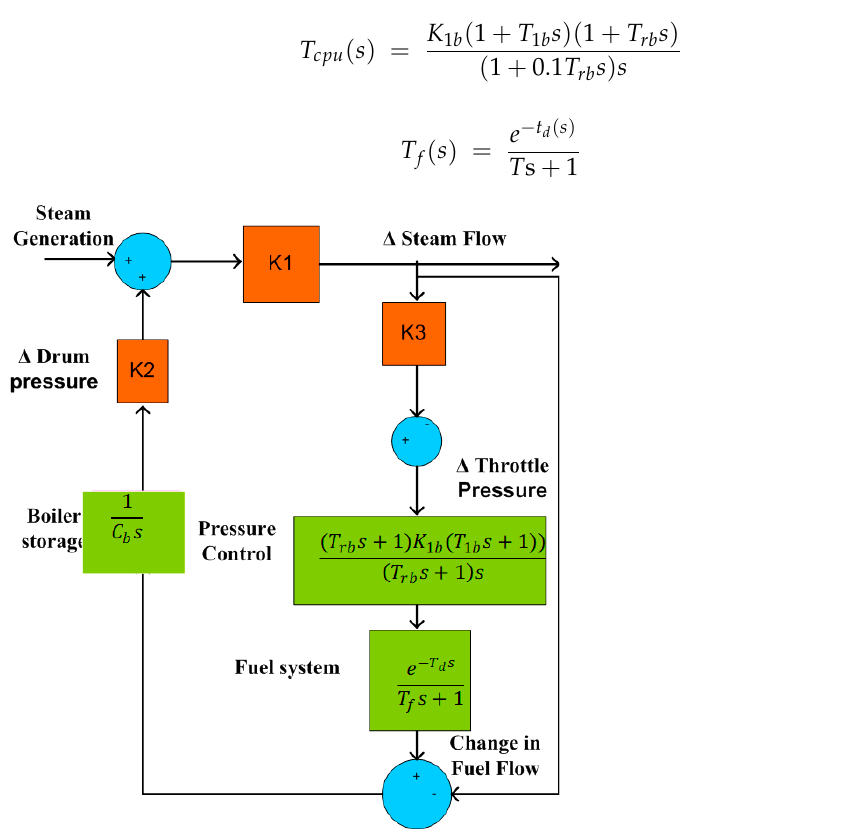
Figure 2. Drum type structure of boiler dynamics.